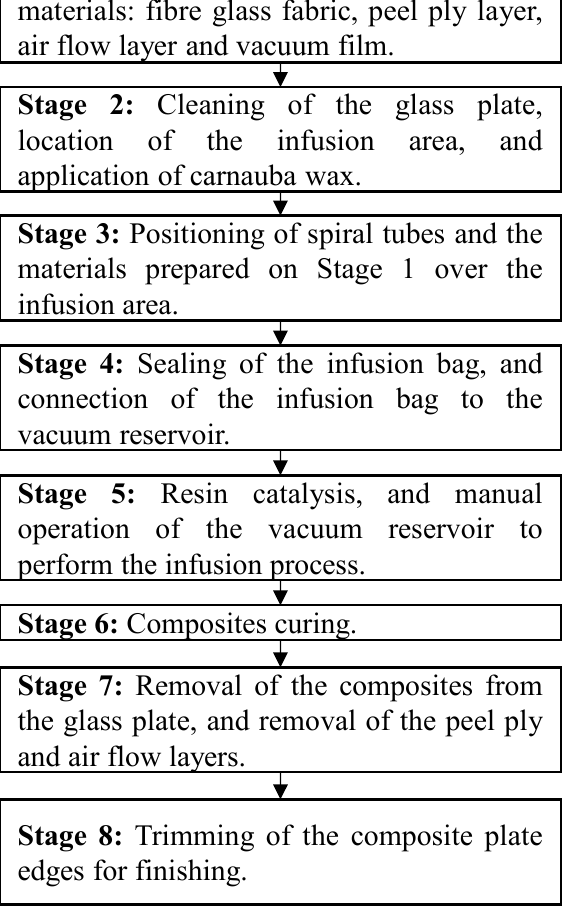
Figure 1. Stages of the composites fabrication